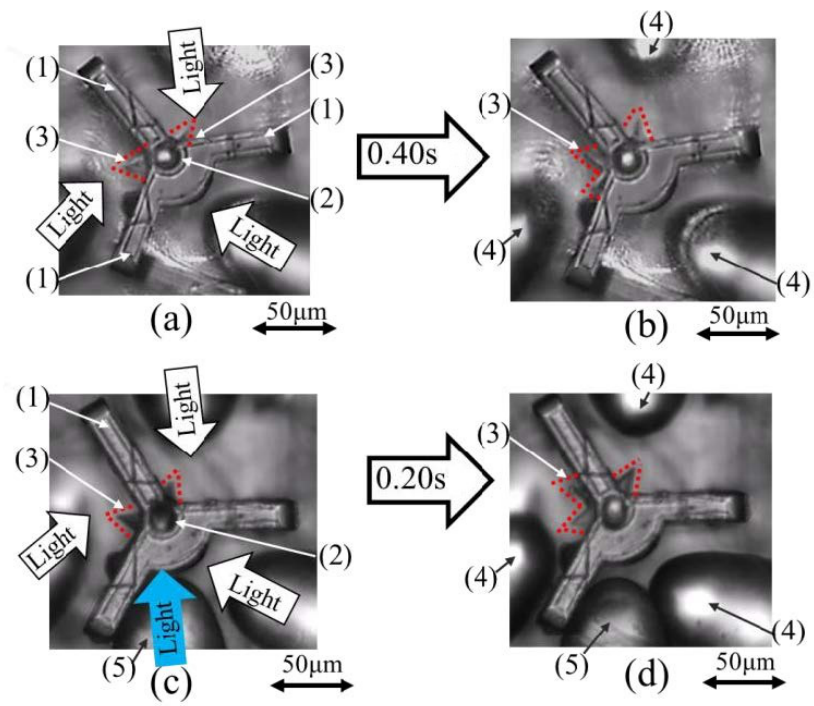
Figure 8. Experiment result of friction reduction: (1) Beam, (2) Shaft, (3) Blade of rotor, (4) Lensed fiber-1 for rotation, (5) Lensed fiber-2 for friction reduction, ( a ) → ( b ) Rotation without light ( ω = 1.15 (rad/s)), ( c ) → ( d ) Rotation with light ( ω = 3.12 (rad/sec)).